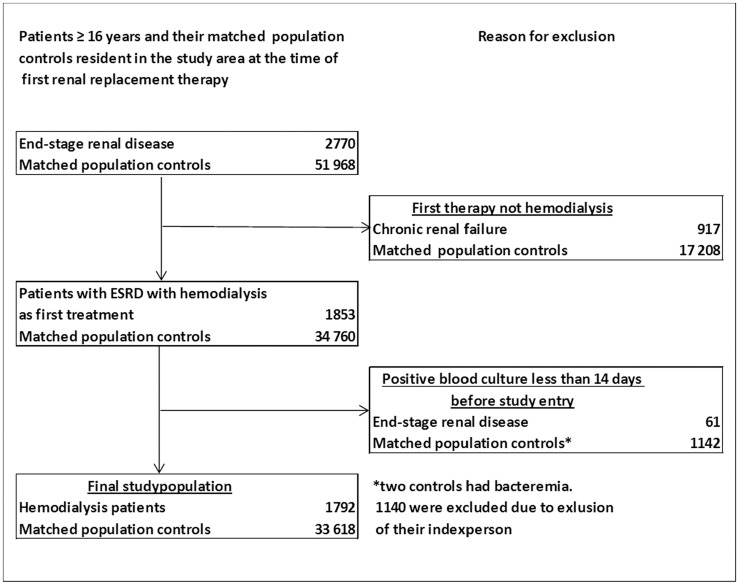
Study population.Overview.